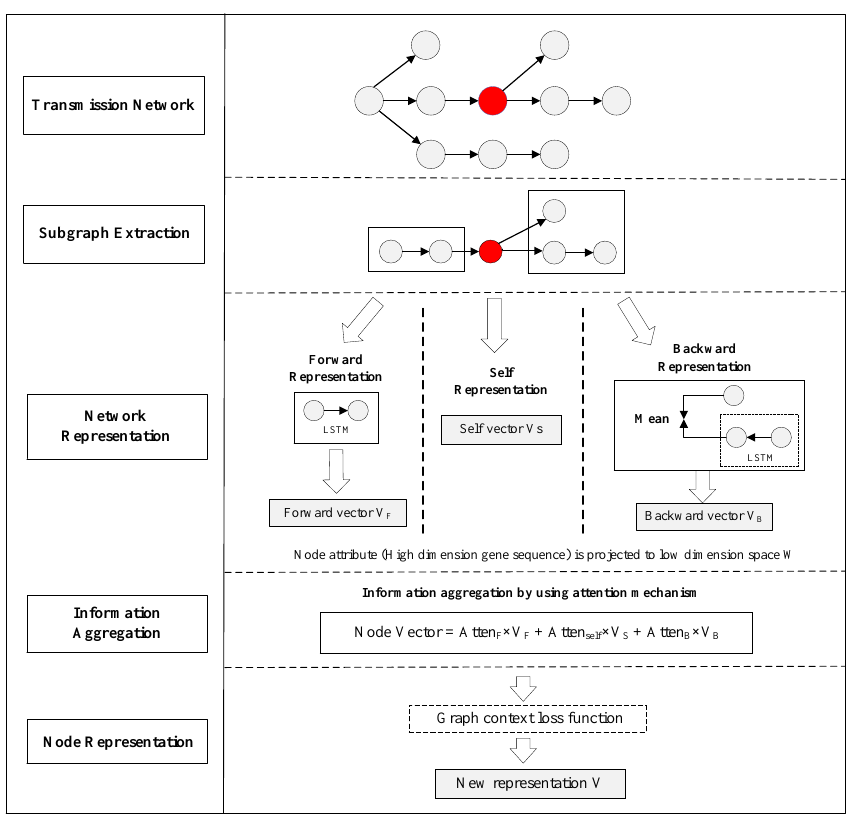
Figure 3. The framework of